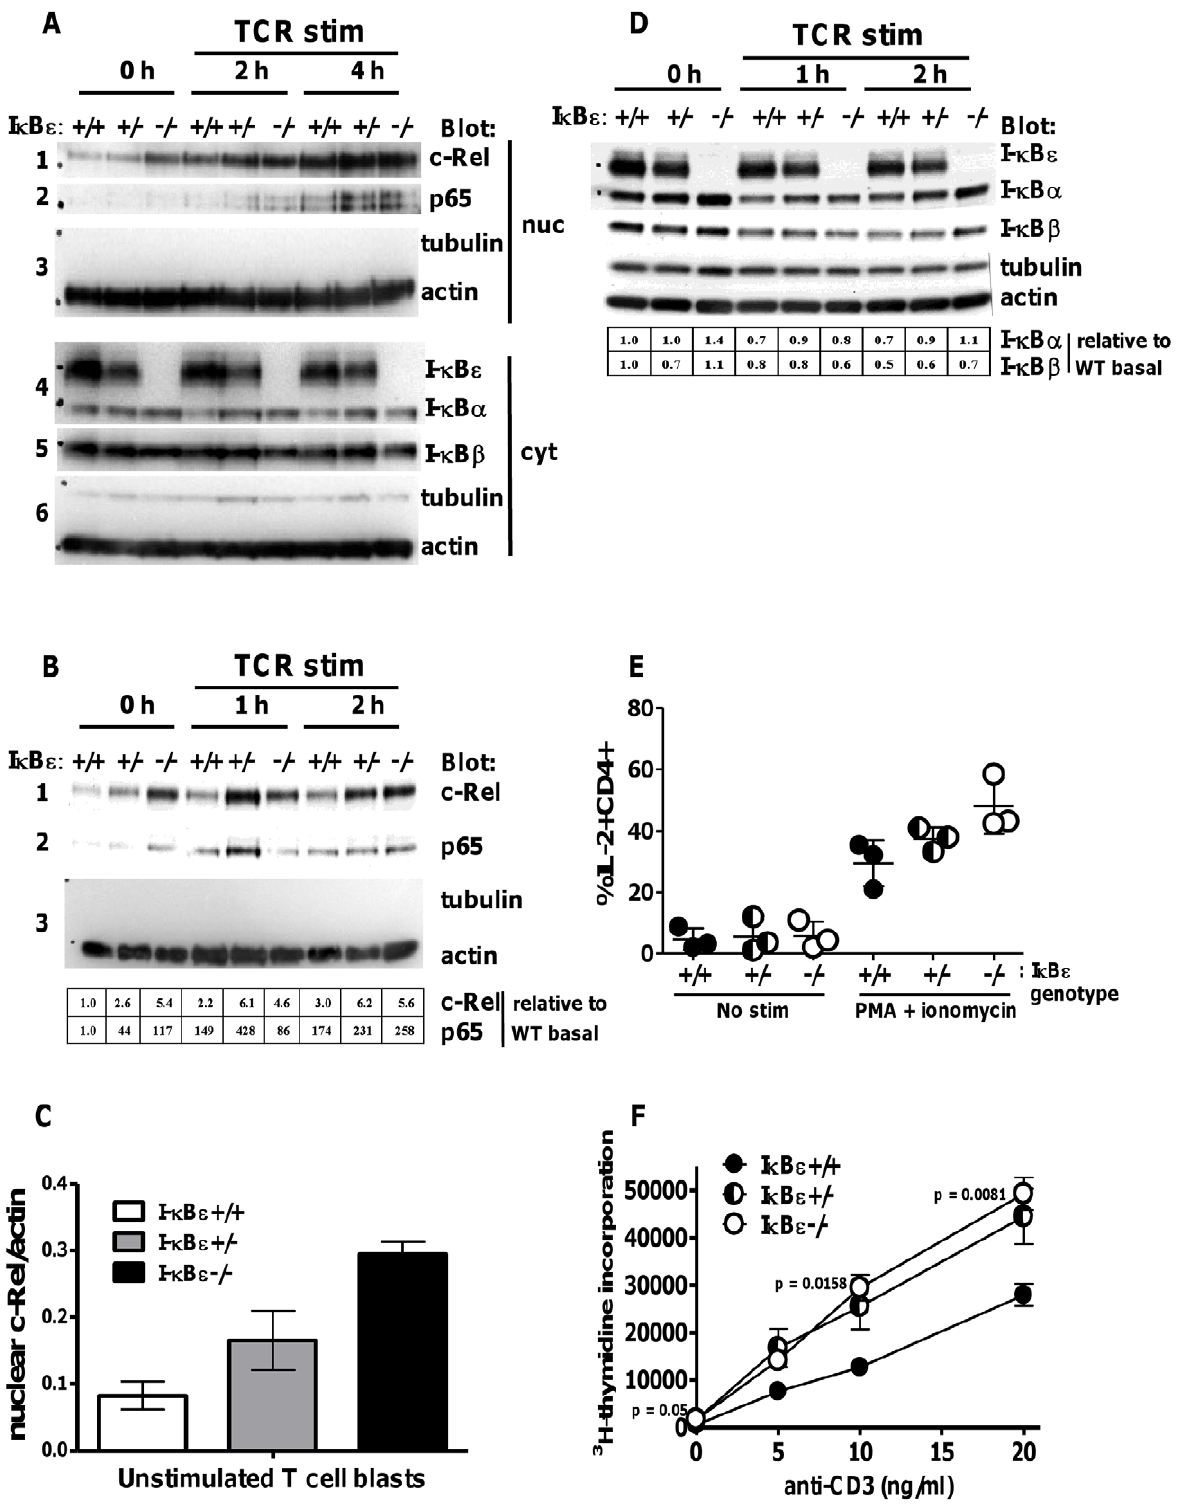
Figure 5. Increased basal nuclear c-Rel, priming for IL-2 expression, and enhanced sensitivity to TCR stimulation in I k B e 2 / 2 T cells. Splenocytes and LNCs from WT C57BL/6J (I k B e + / + , filled circles) mice, or mice hetero- ( + / 2 , half-filled circles) or homozygous ( 2 / 2 , open circles) for I k B e deletion, were cultured with anti-CD3 for 48 hours, washed, then stimulated with IL-2 at day 2 and day 5. On day 7, cells were washed and restimulated, or not, with plate-bound anti-CD3 for up to 4 hours. Extracts from resting and stimulated cells were analysed for (A) nuclear and cytosolic NF- k B and I k B – a four-hour time-course is shown – (B) nuclear NF- k B – a two hour time-course representative of three experiments is shown, with nuclear c-Rel and p65 normalised to actin and expressed relative to values for resting I k B e + / + T cells as indicated. (C) Relative nuclear expression of c-Rel (mean + / 2 SD, n=3 experiments). (D) Cytosolic I k B for experiment shown in (B), with I k B a and - b normalised to actin and